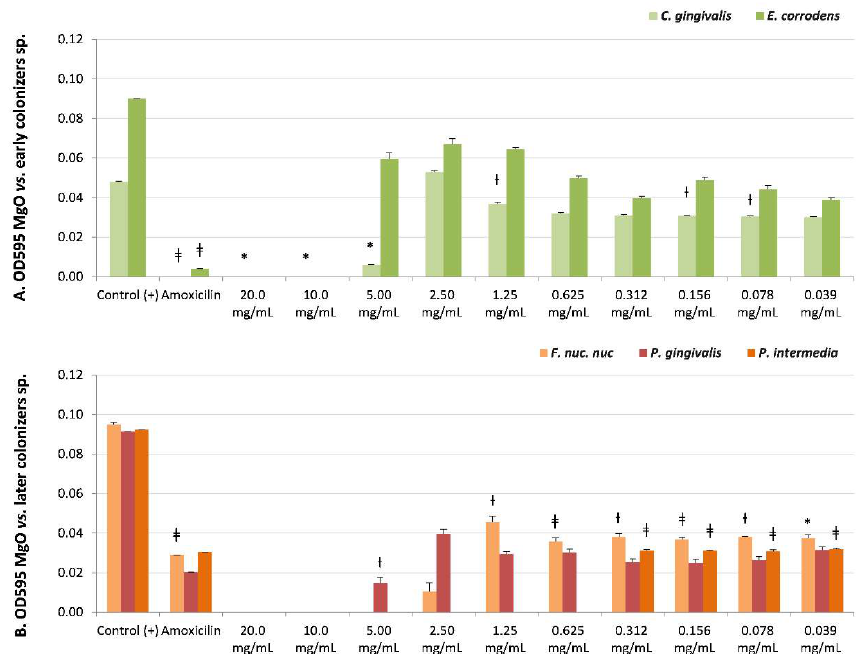
Figure 3. Microbial susceptibility of MgO-NPs against ( A ) early colonizer strains Capnocytophaga gingivalis and Eikenella corrodens and ( B ) later colonizers F. nuc. nuc : Fusobacterium nucleatum subsp. nucleatum , Porphyromonas gingivalis , and Prevotella intermedia . OD595: optical density λ at 595 nm averaged triplicated values; Control (+): bacteria positive control; Amoxicillin: inhibition control, and MgO dissolution used (20 mg/mL to 0.039 mg/mL). Paired differences were determined by Student’s t -test after adjusting per triplicate results as previously described by [27]. The difference between each strain Control + versus each plate dilution is shown as * p < 0.05; ƚ p < 0.01; ǂ p < 0.001. The strain with the opposite result, the most sensitivity to MgO-NPs, was the early colonizer Actinomyces israelii, with an MIB at 0.039 mg/mL ( p < 0.01, CFUs = 0) (Table 2 and Figure 2B).